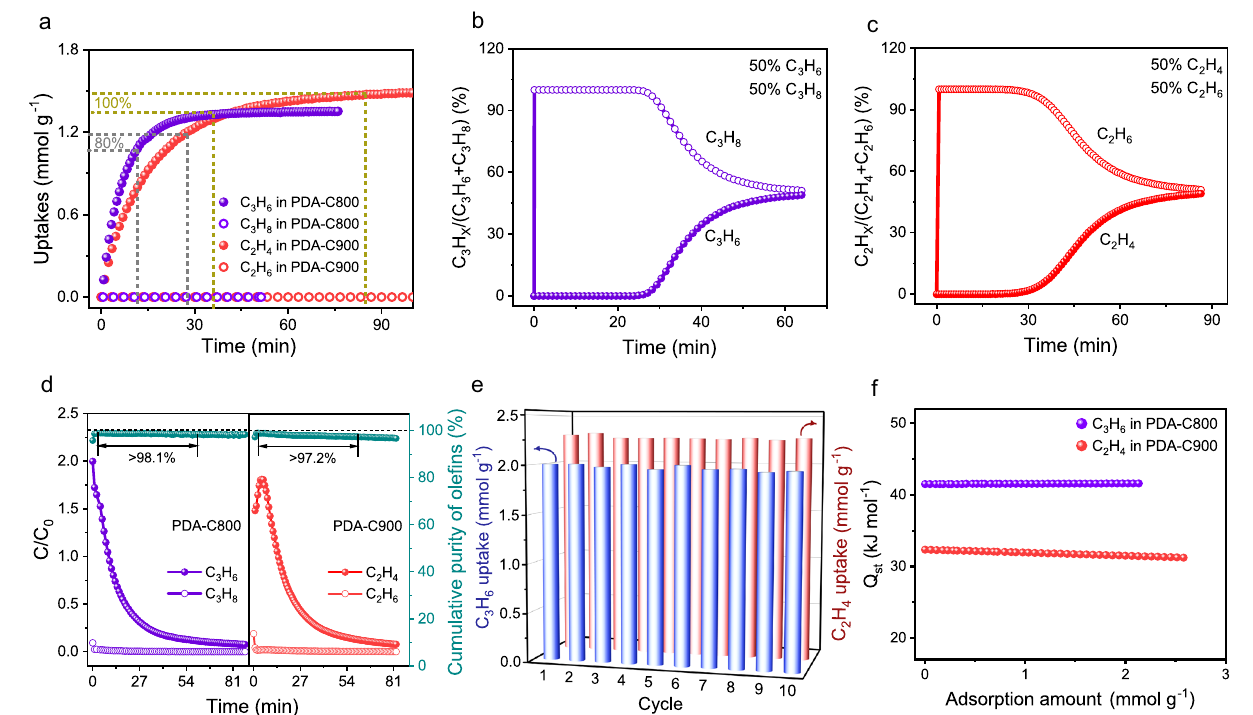
Fig. 5 | Ole fi n/paraf fi n dynamic separation and regeneration property. a Time- dependent gas uptake pro fi les of C 3 H 6 on PDA-C800 and C 2 H 4 on PDA-C900 at 308K and 0.5bar. The time required to reach 80% of the saturated ole fi n uptake and equilibrium is depicted as dashed lines. Experimental column breakthrough curvesforthemixturesof b C 3 H 6 /C 3 H 8 (50/50, v/v)onPDA-C800and c C 2 H 4 /C 2 H 6 (50/50, v/v) on PDA-C900 at 298K with a constant fl ow rate of 1.5mL/min;